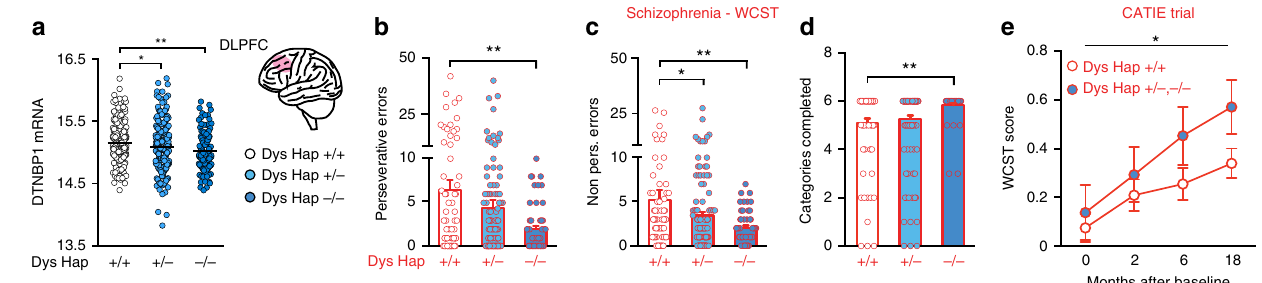
Fig. 1 Genetic variations reducing dysbindin-1 are associated with better executive functions in antipsychotic-treated subjects. a Reduction of dysbindin-1 expression in the DLPFC of Dys Hap + / − and − / − human subjects (light and dark blue circles, respectively) compared to Dys Hap + / + (white circles) ( n = 594; one-way ANOVA, F (2, 591) = 5.70, p < 0.005). Analysis with the R package haplo.stats v1.7.7 yielded a global p value of 3.5 × 10 − 7 for DTNBP1 at the gene level, which was in part driven by the speci fi c Dys haplotype ( p = 2.54 × 10 − 5 ), associated with lower expression (i.e., Dys Hap + / + > Dys Hap + / − > Dys Hap − / − ). b – d Patients with schizophrenia with reduced dysbindin-1 expression (Dys Hap − / − ) made b fewer perseverative ( n = 259; one- way ANOVA, F (2, 251) = 4.64, p < 0.01), and c fewer non-perseverative errors (one-way ANOVA, F (2, 251) = 4.21, p < 0.01) on the WCST, and d passed more categories (one-way ANOVA, F (2, 251) = 4.74, p < 0.01). No Dys-haplotype-dependent differences were present in demographical characteristics or in the duration or dosage of antipsychotic treatments (see Supplementary Table 1). All single-nucleotide polymorphisms (SNPs) were in Hardy – Weinberg equilibrium (HWE) for healthy subjects and patients with schizophrenia (see Supplementary Table 2). e Patients with schizophrenia with reduced dysbindin-1 (Dys Hap + / − and − / − , blue circles), who were enrolled in the NIH CATIE trial showed better WCST performance than those with the Dys Hap + / + (white circles) genotype. The WCST score was calculated by averaging z-scores for preservative errors and categories achieved ( n = 359; two- way ANOVA, time effect, F (3, 1046) = 5.03, p < 0.005; genotype effect, F (1, 1046) = 4.38, p < 0.04). Error bars represent S.E.M. * p < 0.05, ** p <